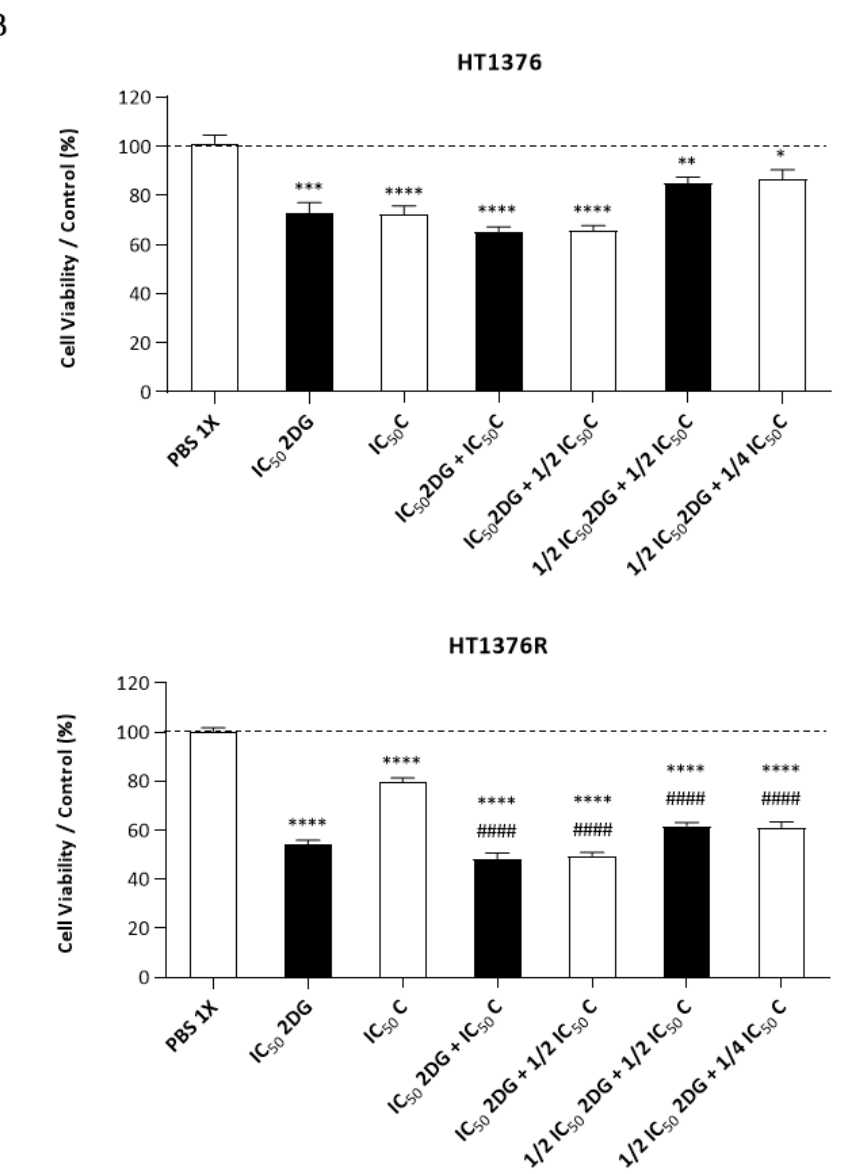
Figure 10. Effect of 2DG and cisplatin on the viability of HT1376 and HT1376R urothelial bladder carcinoma cell lines, detected by the sulforhodamine B assay at 72 h post-treatment. In ( A ), dose response curves and IC 50 values are shown. Results are expressed as normalized means ± SD of at least 3 independent experiments, each one in triplicate. The equation for IC 50 determination is Y = Bottom + (Top − Bottom)/(1 + 10 ((LogIC50 − X)*HillSlope)) . * above the graph lines: ** p < 0.01, *** p < 0.001 and **** p < 0.0001 for treatment (2DG or cisplatin) of HT1376R versus HT1376 cells; * below the graph lines: * p < 0.05, ** p < 0.01, *** p < 0.001 and **** p < 0.0001 for treatment (2DG or cisplatin) of HT1376 (black *) or HT1376R (grey *) cells versus control condition (PBS 1 × ). In ( B ), the effect of 2DG and cisplatin IC 50 s in HT1376 and HT1376R, administered alone and in combination (at indicated dosages) is shown. Results are expressed as normalized means ± SEM of at least 3 independent experiments, each one in triplicate. * p < 0.05, ** p < 0.01, *** p < 0.001 and **** p < 0.0001 for treatment (2DG and cisplatin, alone or combined) versus control condition (PBS 1 × ). #### p < 0.001 for combined treatment (at indicated dosages) versus cisplatin IC 50 treatment.